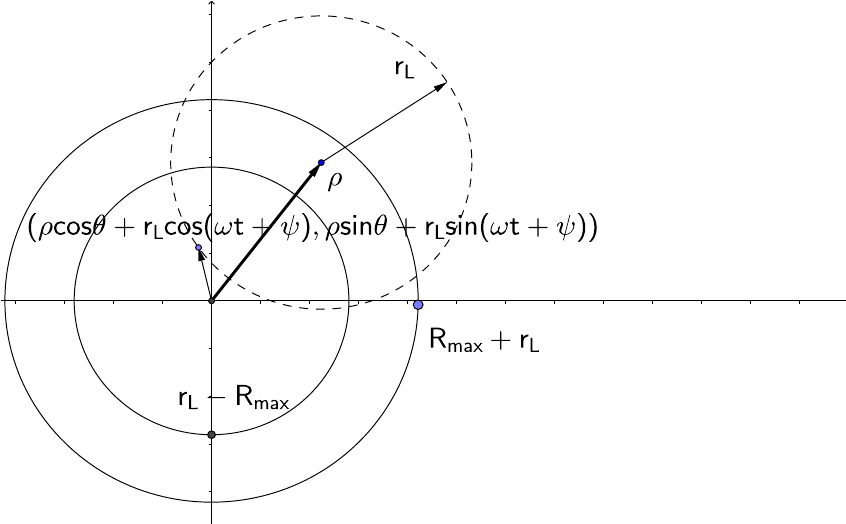
Figure 1. x-y trajectory projections for r L ≥ R max . Shown is the annular region between concentric circles with the origin (the emitter position) as center and radii r L − R max and r L + R max , respectively. For an impact parameter at a distance ρ from the center in the annular region, a circle with radius r L (dashed) represents the projection of the perturber path in the x-y plane. Hence a point on that circle is (cid:0) (cid:1) ρ cos θ + r L cos ( ω t + ψ ) , ρ sin θ + r L sin ( ω t + ψ ) , with ψ the angle on the dashed circle. This must be no more than R max away from the center, else this perturber does not contribute.